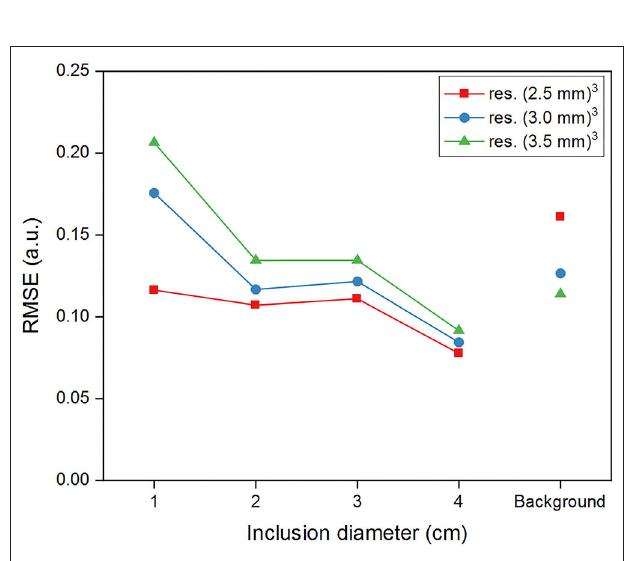
FIGURE 7 | Root-mean-square-error (RMSE) of G’ reconstructed within the inclusions and in the background for MRE data at different spatial resolutions. for the finest resolution, as opposed to the inclusions where the errors increased with increasing voxel size.